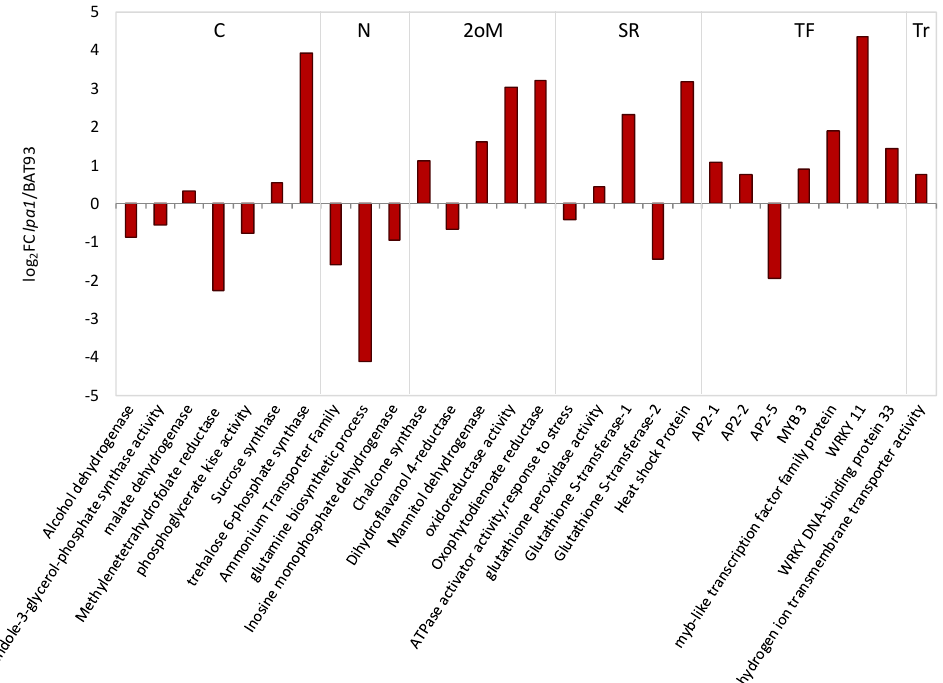
Figure 4. Relative expression level of nodule ‐ function related genes in nodules of water stressed lpa1 plants compared to BAT 93. For the water stress treatment, plants were analyzed at 14% soil moisture. Values refer to the log 2 of the fold change ratio between lpa1 and BAT93. The genes functional categories are: carbon metabolism (C), nitrogen metabolism (N), secondary metabolism (2oM), stress response (SR), transcription factors (TF) and transport (Tr).